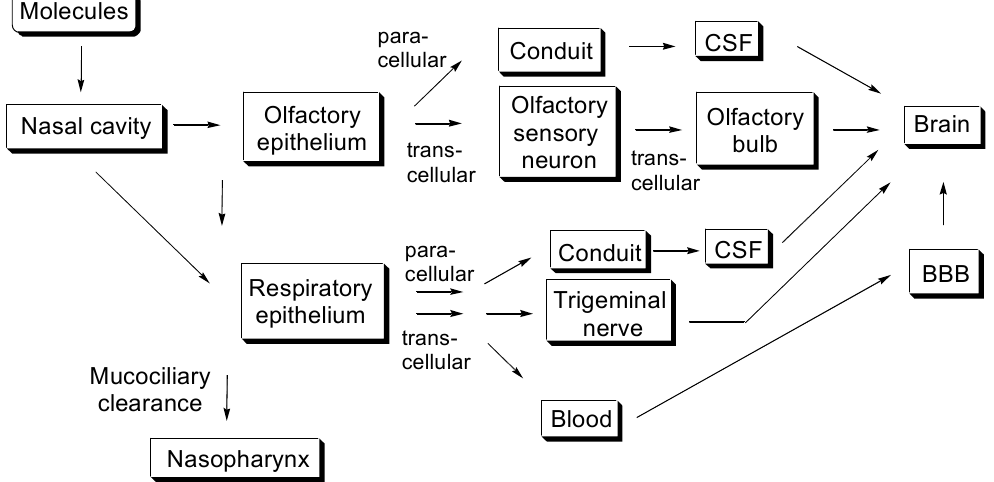
Figure 1. Schematic overview of several molecular pathways after intranasal drug administration. CSF stands for cerebrospinal fluid. BBB stands for blood–brain barrier.